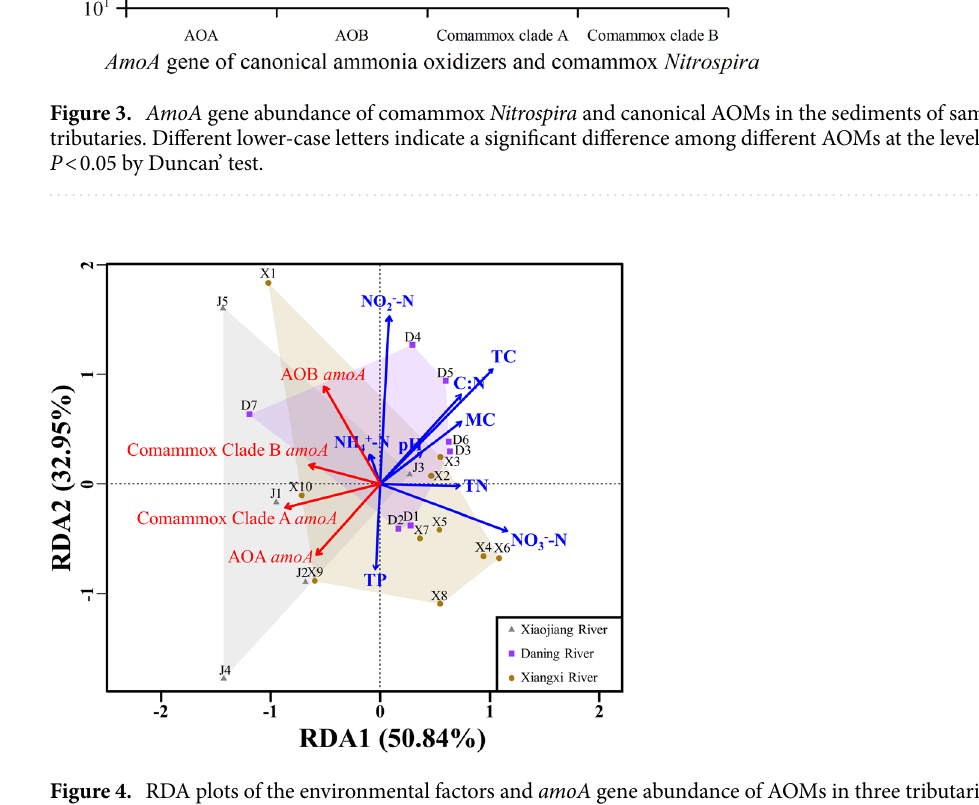
Figure 4. RDA plots of the environmental factors and amoA gene abundance of AOMs in three